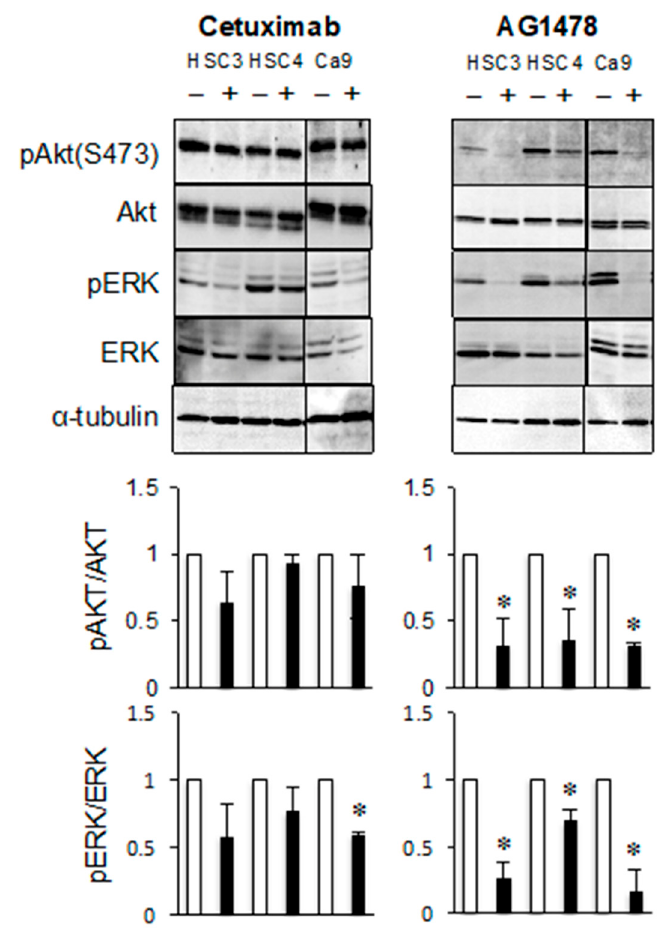
Figure 3. AG1478 and cetuximab have different inhibitory effects on ErbB3 signaling pathway of cancer cells. The HSC3, HSC4, and Ca9-22 cells were treated with cetuximab or AG1478 and the phosphorylation and protein levels of AKT and extracellular signal-related kinase (ERK) were determined by western blotting analysis. α -tubulin was used as the loading control. * Significantly different from control, p < 0.05. Experiments were performed three times independently.